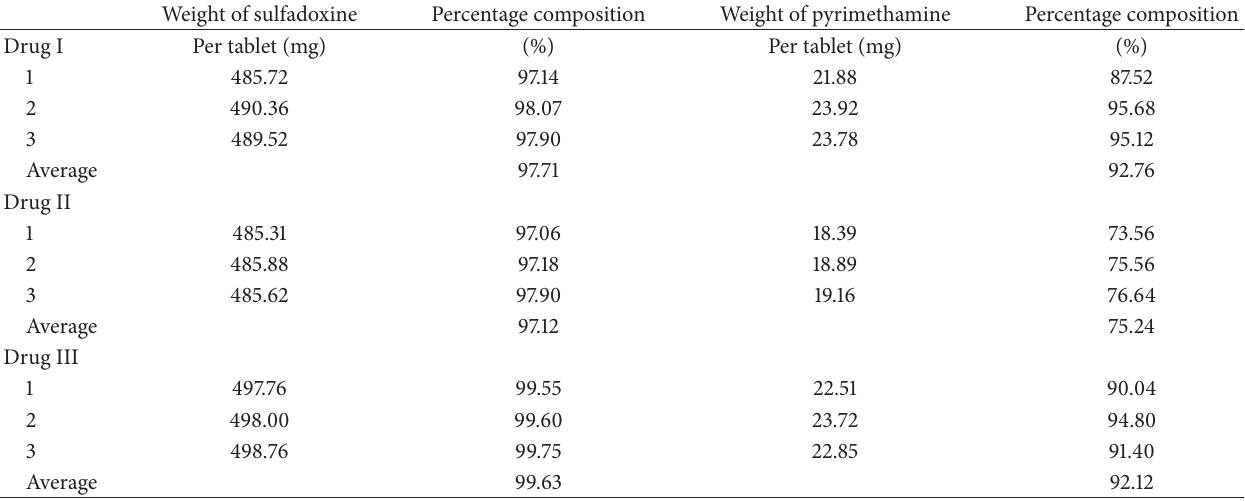
Table 3: Calculated weight in milligram and percentage composition of sulfadoxine and pyrimethamine in Drugs I, II, and III. Weight of sulfadoxine